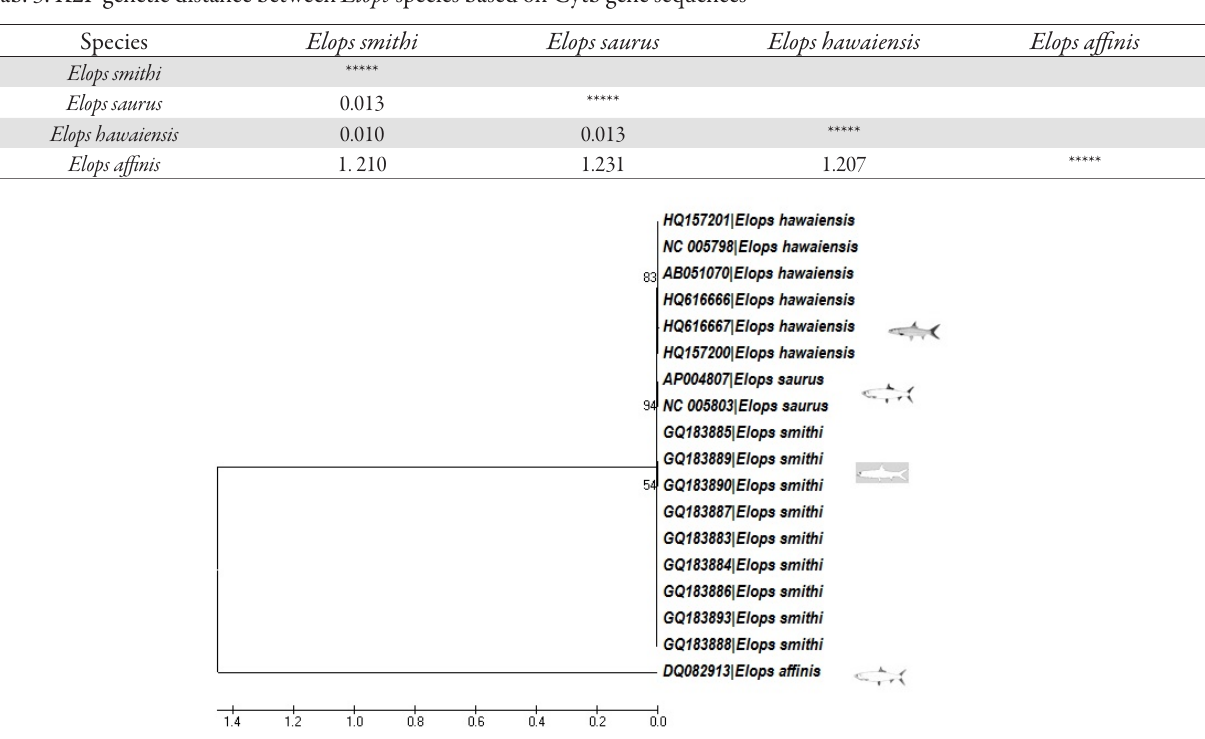
Tab. 3. K2P genetic distance between Elops species based on Cytb gene sequences